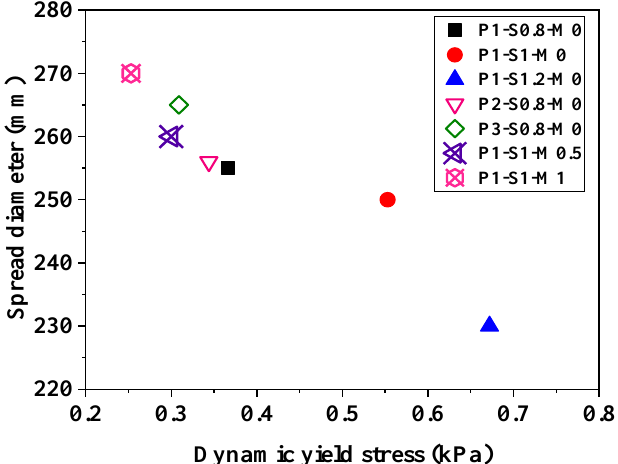
Figure 7. The relationship between the dynamic yield stress and the spread diameter of AAFS mor- tar.